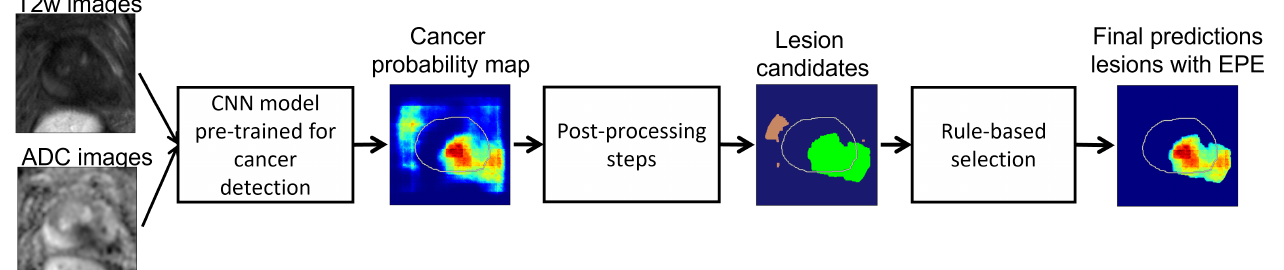
Figure 1. Flowchart describing our method for generating spatial predictions of cancer lesions with extraprostatic extension. A convolutional neural network takes in T2w and ADC images and outputs a probability map for cancer. We apply post-processing steps of masking, thresholding and connected components to the probability map to obtain a set of lesion candidates. We check each lesion candidate against a set of heuristic rules and determine which are the lesions with suspected extraprostatic